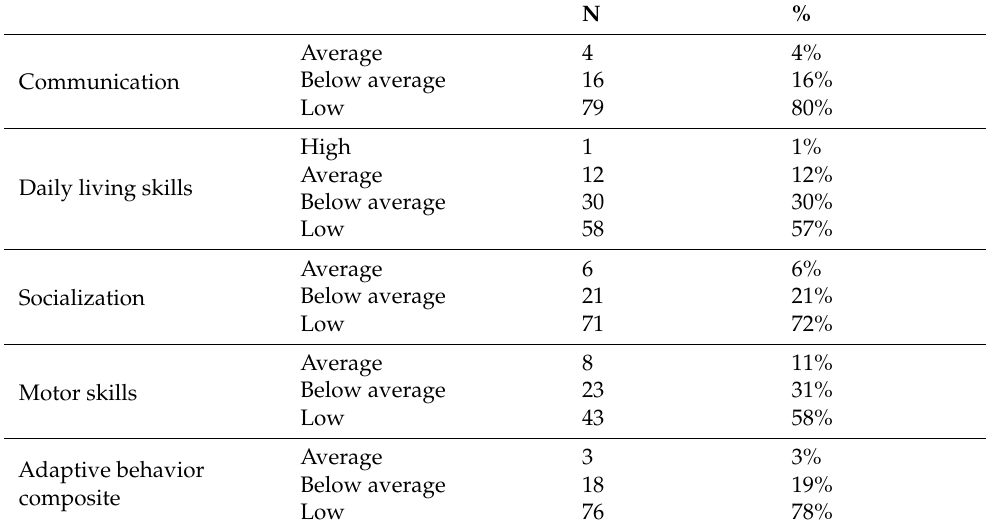
Table 9. Psychological assessment.